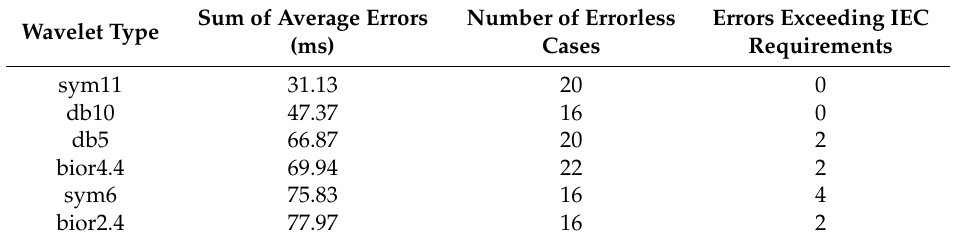
Table 2. Watermarking performance with use of different wavelets (40 iterations for 4 intervals, coding bit depth from 1 to 5 and textual or numerical watermark).